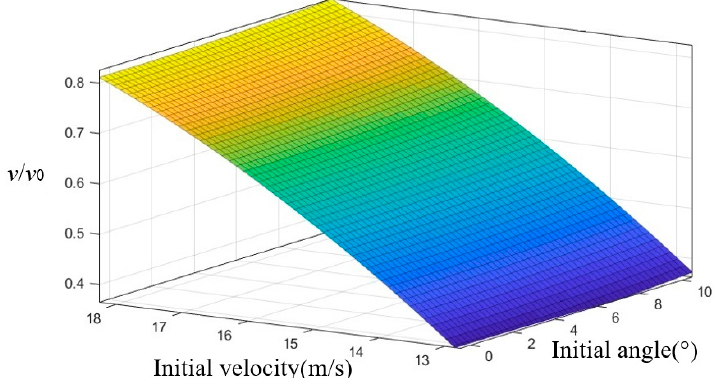
Figure 23. Fi tt ing function image of vehicle velocity v with respect to inclination angle x 1 and water-exit velocity x 2 .